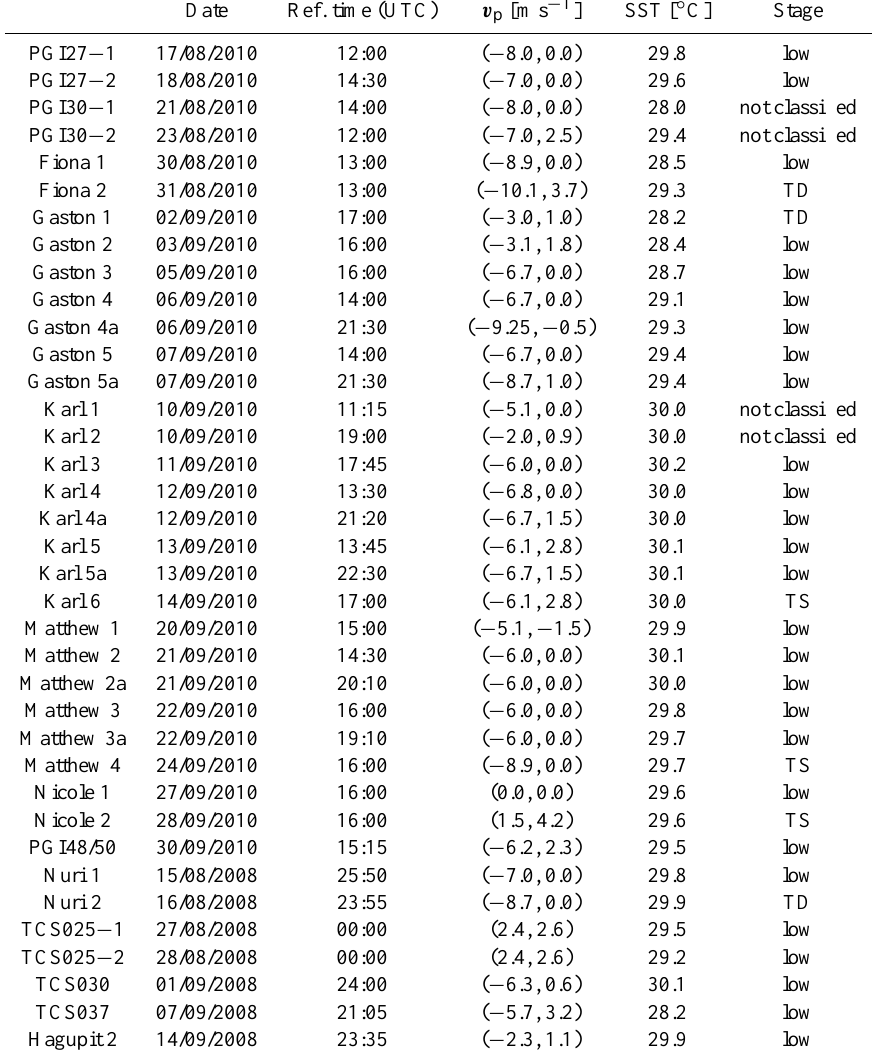
Table 1. Observational cases that enter the scatter plots in Sect. 5.1. The stage of each disturbance is as recognized by NHC at the time of observation. “Low” stands for either a tropical wave or a weak tropical disturbance, while TD indicates a tropical depression and TS a tropical